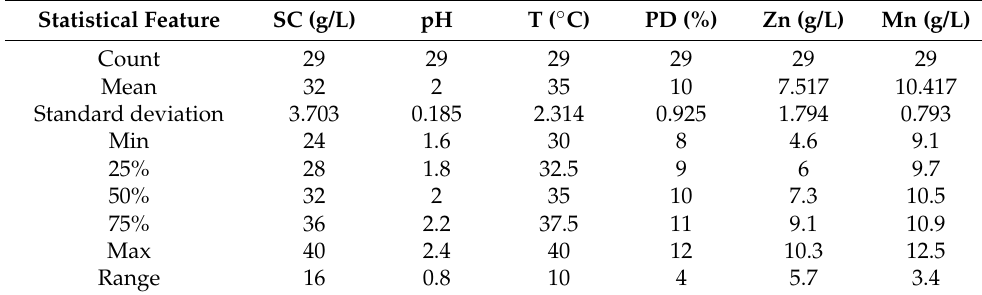
Table 1. Statistical summary of the